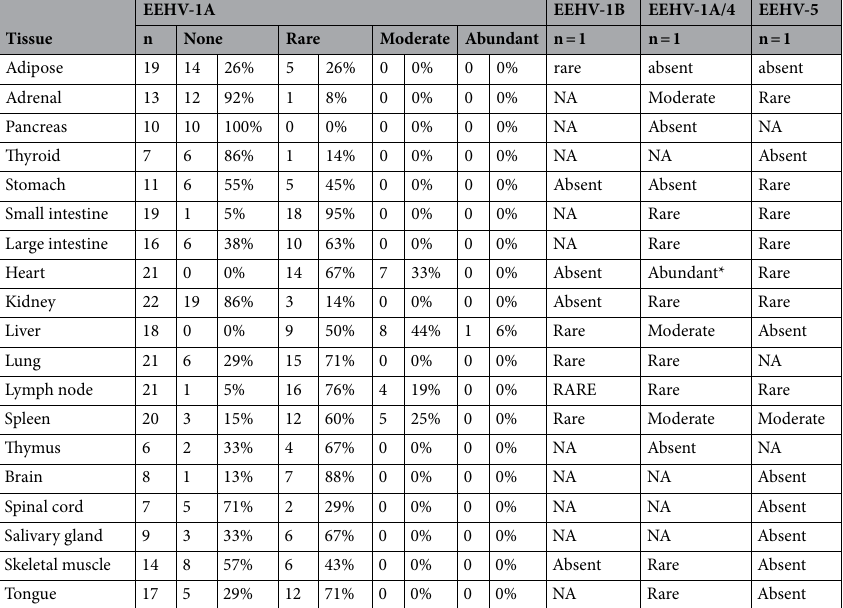
Table 3. Semi-quantification of intranuclear inclusion bodies in organs from Asian elephant endotheliotropic herpesvirus-haemorrhagic disease fatalities in Europe. NA; tissue not available, * located primarily in endothelial cells of myocardial